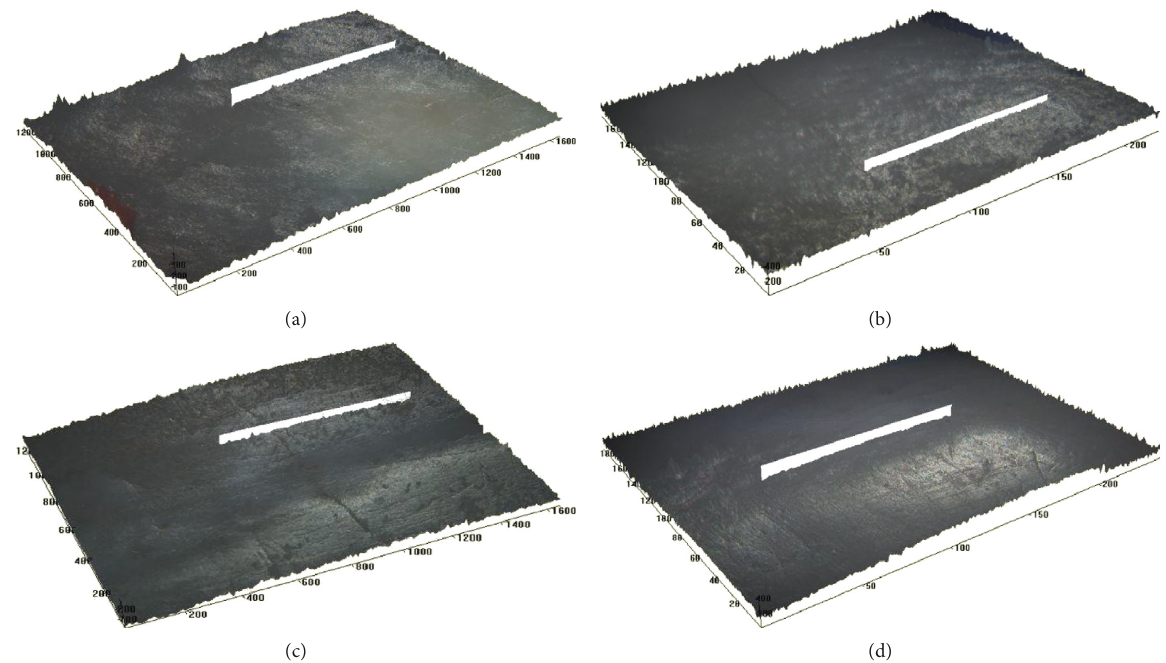
Figure 1: (a) Surface roughness of teeth sample from group C at baseline, under 10x magnification as observed under optical profilometer; (b) surface roughness of teeth sample from group C at 10 min after exposure to fortified fruit beverage, under 10x magnification as observed under optical profilometer; (c) surface roughness of teeth sample from group C at 20 min after exposure to fortified fruit beverage, under 10x magnification as observed under optical profilometer; and (d) surface roughness of teeth sample from group C at 30 min after exposure to fortified fruit beverage, under 10x magnification as observed under optical profilometer.